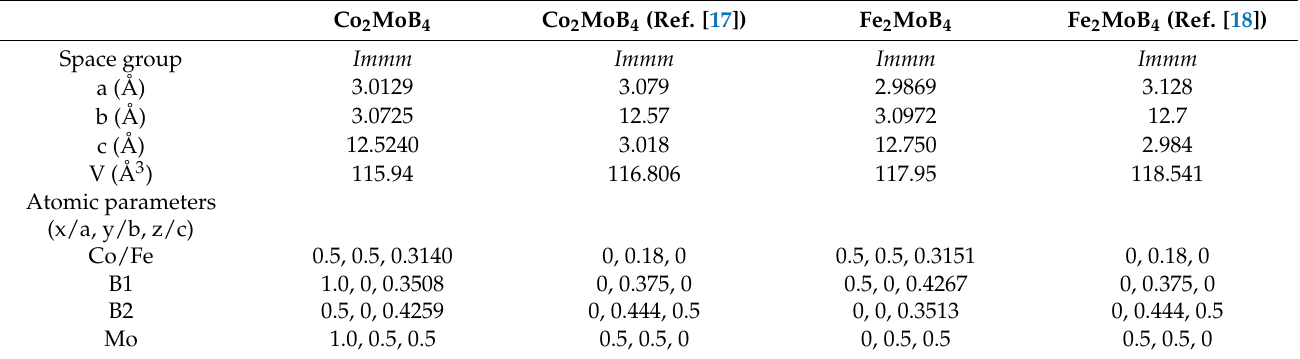
Table 1. A brief summary of the lattice parameter and atomic parameters of Co 2 MoB 4 and Fe 2 MoB 4 in this work and previous reference.